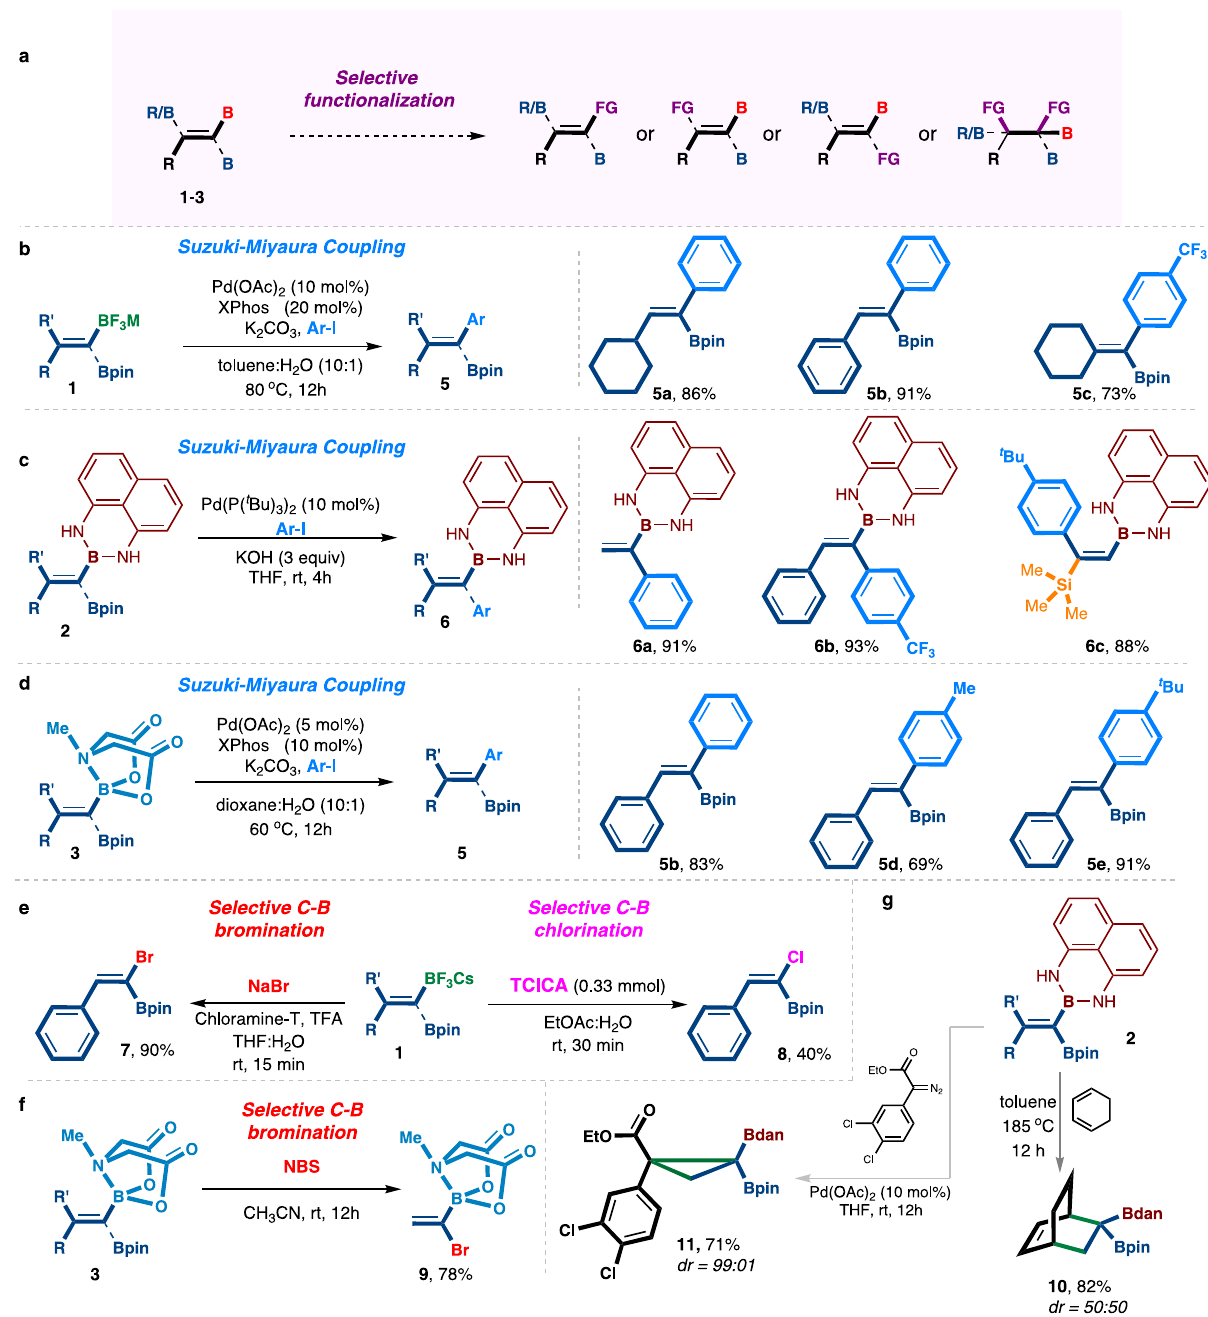
Fig. 5 | Representative Synthetic utility of polyBorylated-Alkenes (1-3). a General scheme of the representative applications . b Selected examples of Suzuki – MiyauraCouplingof 1 . c RepresentativeSuzuki-MiyauraCouplingreactions on 2 . d Selected examples of arylation reactions on 3. e Presented